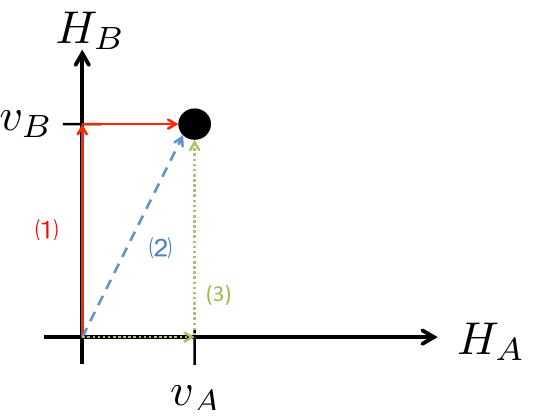
Figure 2 . This (cid:12)gure shows three possible trajectories of the phase transitions. In this (cid:12)gure, v and v are the vacuum expectation values of the H B black point represents the true vacuum at the zero temperature. We consider only the path